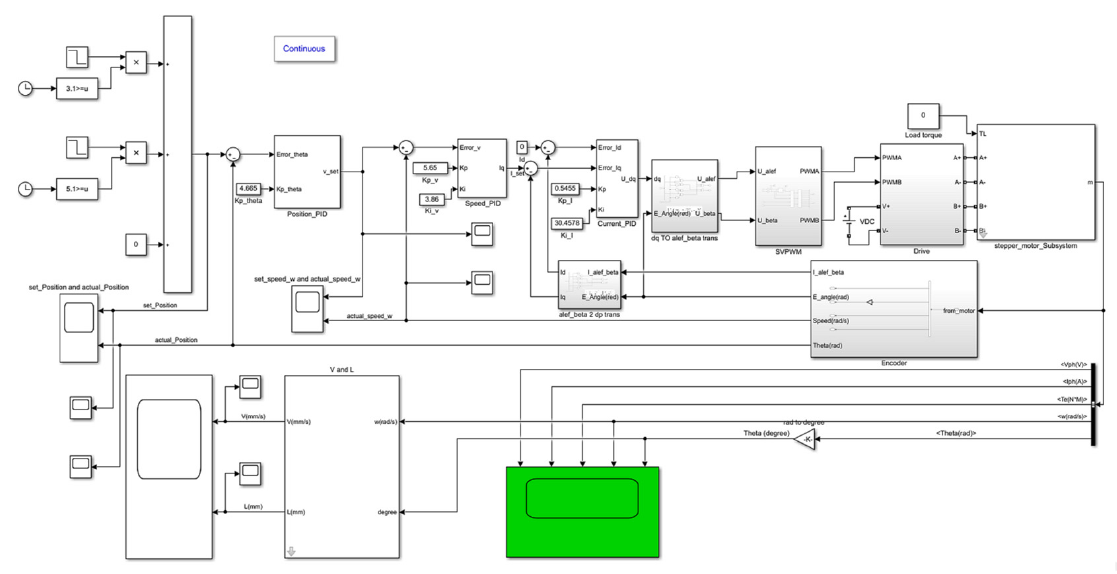
Figure 8. Incremental PID-based model for automatic control system of cu tt er height o ff the ground.